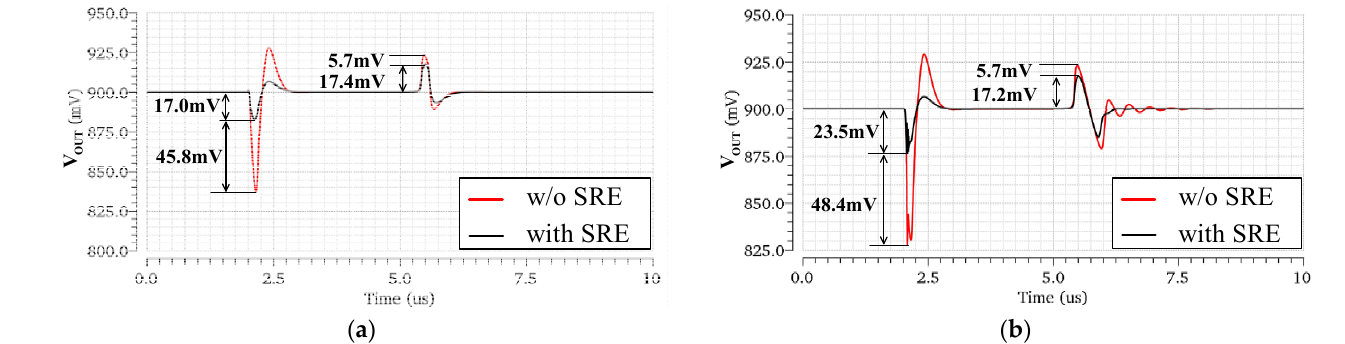
the output voltage are simulated with and without the SRE circuit. For a fair comparison, the only difference is that the gate voltages of the transistors M14 and M20 are biased to a fixed value, while the circuit structure, transistor size, and bias current remain the same. As